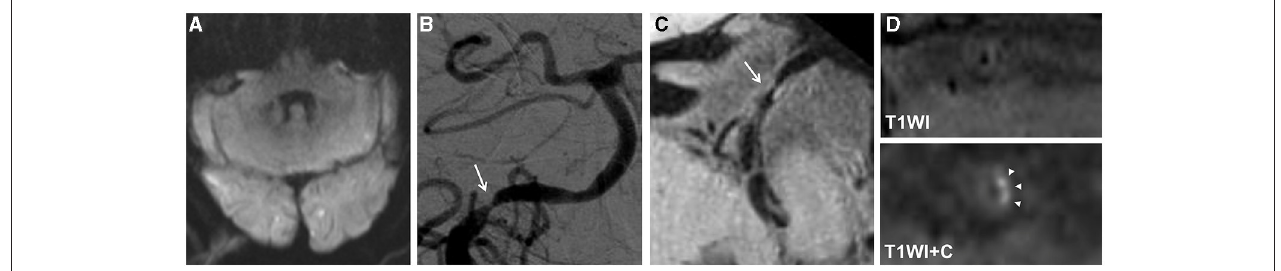
FIGURE 2 | An 80-year-old man presented with dizziness for 15 days. The diffusion-weighted imaging (DWI) showed infarcts of bilateral occipital lobes and left cerebellum (A) . The digital subtraction angiography (DSA) showed severe stenosis at the V4 segment of the right vertebral artery (arrow) (B) . The high-resolution